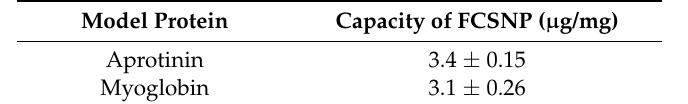
FCSNP = Functionalized core-shell silica nanoparticles; Capacity of FCSNP (µg/mg) = amount of protein (µg) captured per milligram of nanoparticles.